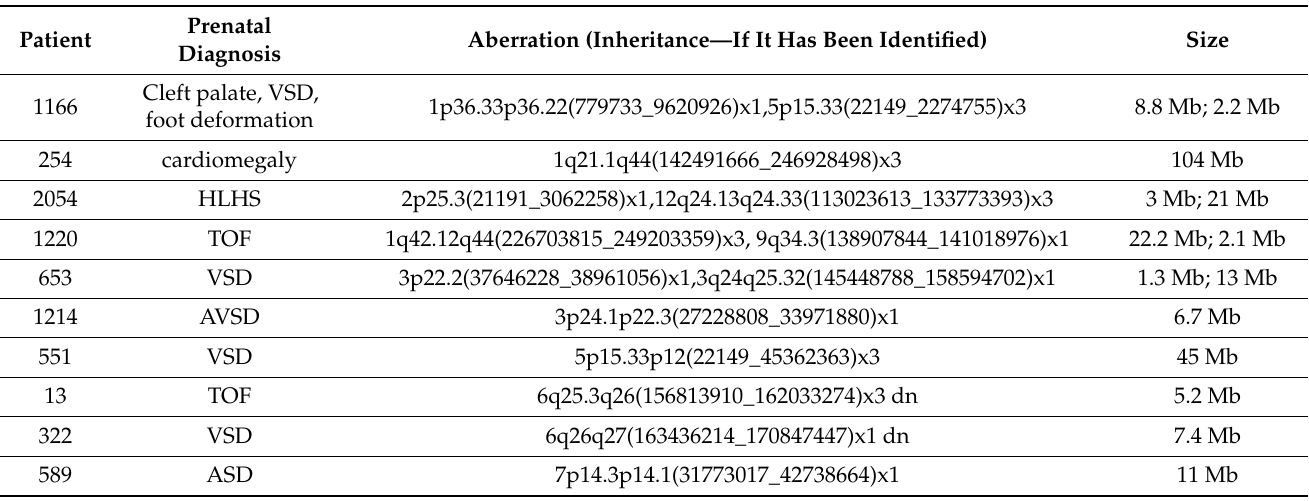
Table 2. Pathogenic structural aberrations found in our cases.